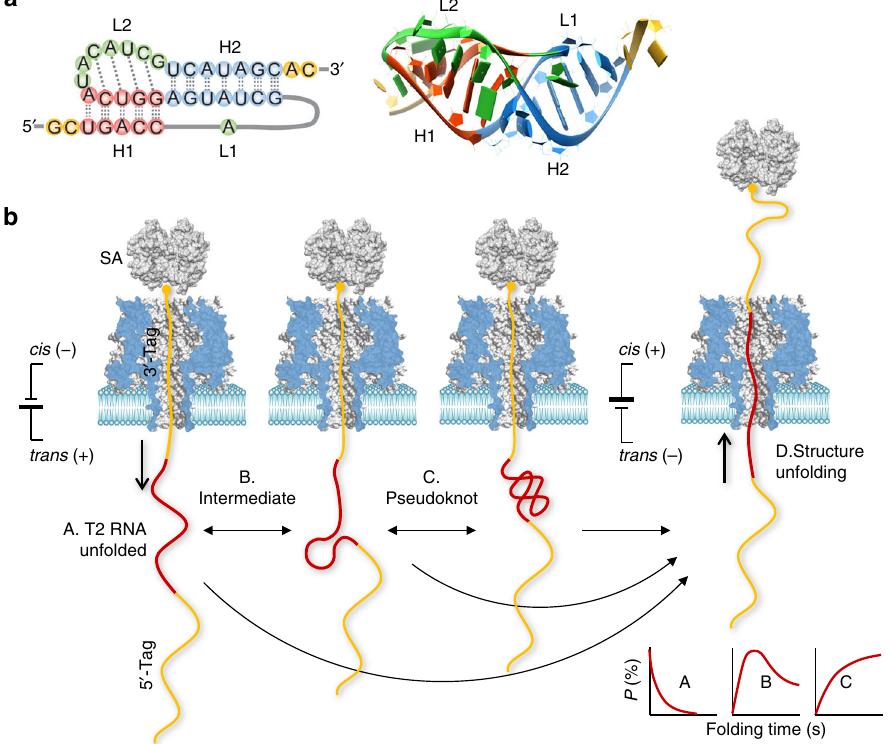
Fig. 1 Single-molecule detection of RNA folding in a protein nanopore. a 2D (left) and 3D (right) structures of the pseudoknot from the 5 ʹ end gene 32 messenger RNA of bacteriophage T2 (PDB id: 2tpk), which contains two helices, H1 (red) and H2 (blue), and two loops (green), L1 and L2. The base triple interactions between loops and helices (identi fi ed by RNAview 70 ) and the coaxial stacking between the two helices are illustrated. b Nanopore detection of T2 RNA folding states and the folding pathway. The detection was facilitated by a complex probe containing a chimera of the 5 ʹ -DNA tag, T2 RNA, and 3 ʹ - DNA tag. The 3 ʹ end is attached to streptavidin (SA) to immobilize the probe. Upon immobilization, the T2 RNA starts to fold from the single-stranded form in the trans solution. After a pre-de fi ned folding time, the folding process is terminated at an intermediate state (B) or the pseudoknot structure (C) by using a negative voltage that disrupts the folding structure (D). The unfolding signatures reveal the folding state (B and C) and unfolding state (A). The folding time-dependent population of the identi fi ed folding states allows establishment of the pseudoknot folding